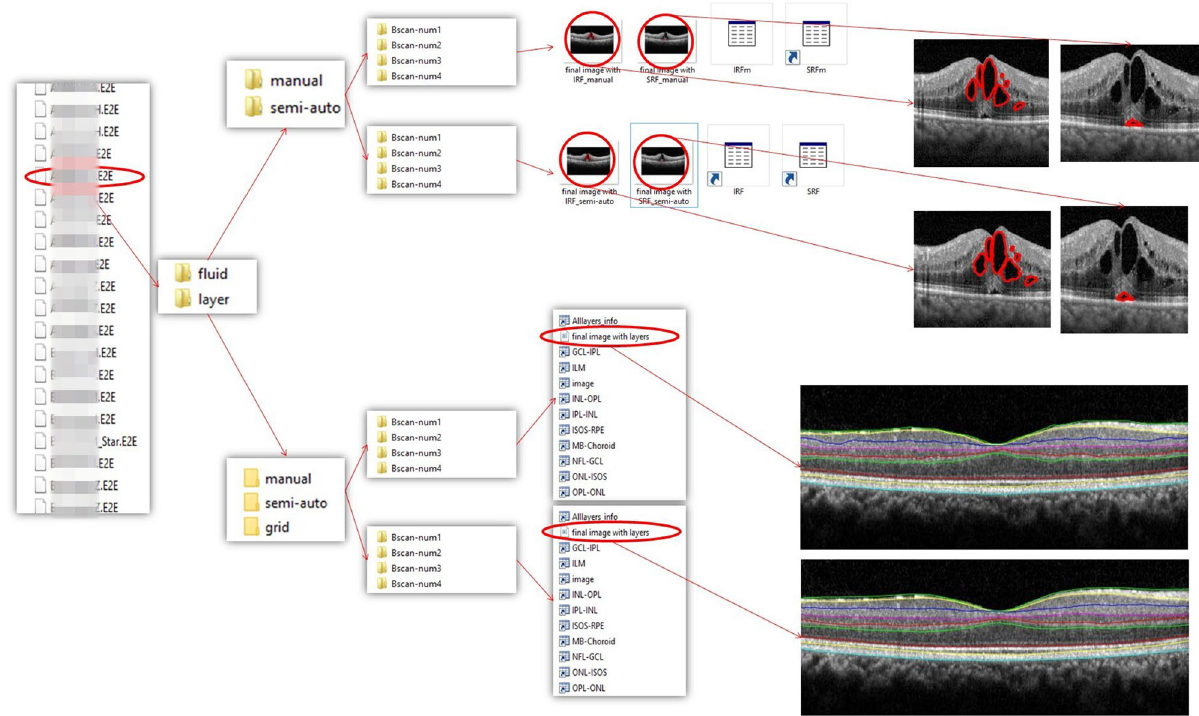
Figure 7. The structure of the DME dataset we worked on and a hierarchical model for the discretely generated folders constituting the software’s